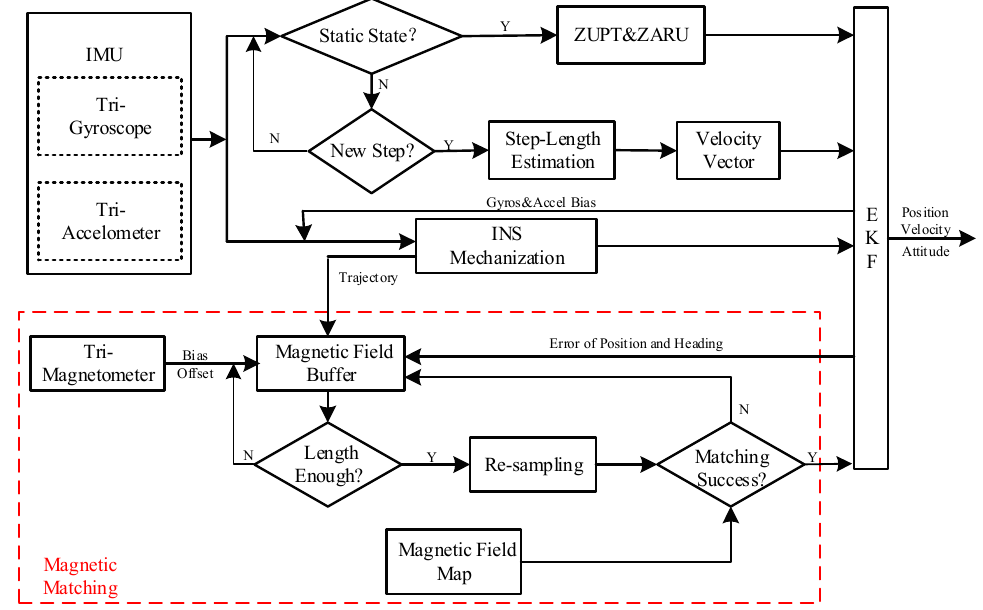
Figure 1. Detailed indoor positioning solution process.